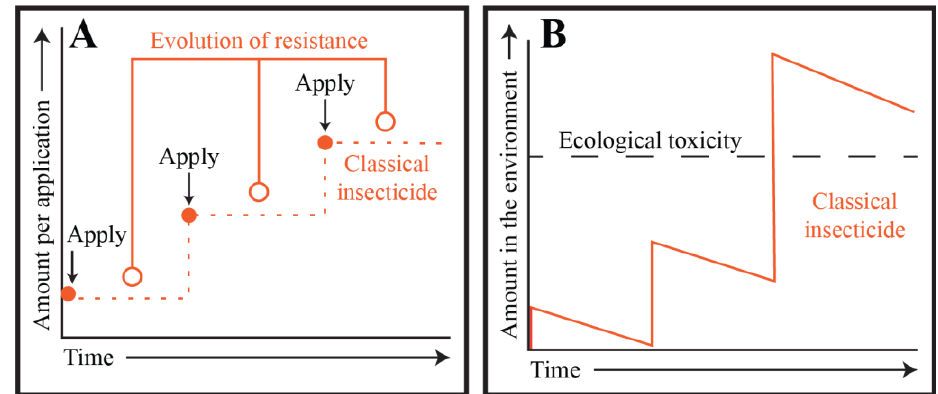
Figure 3. A model of accumulation and resistance of insecticides, known as the pesticide tread- mill. ( A ) Resistance evolves (open circles) against classical insecticides following their repeated application (closed circles) because of selective pressure on their highly specific neurological targets. Therefore, to achieve the same level of insect control, higher dosages are progressively applied as the populations gain resistance. ( B ) Classical insecticides persist in the environment and require increased dosage application to manage resistant populations. Therefore, classical insecticides accumulate over time and eventually lead to ecological damage.